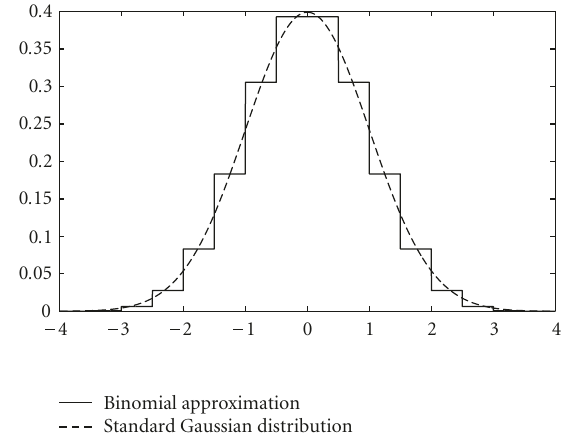
Figure 4: Binomial approximation of the standard Gaussian distri- bution for K =